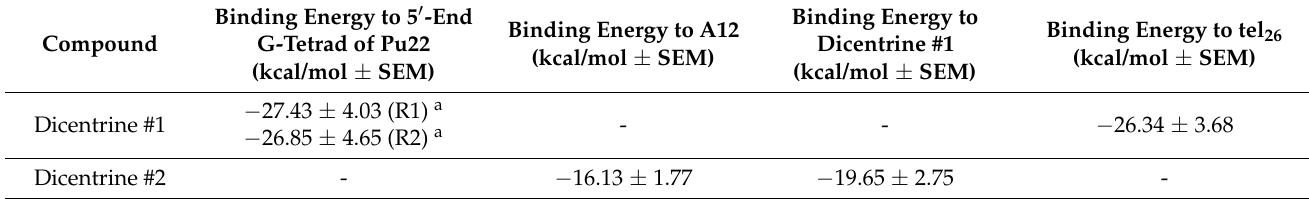
Table 4. Delta energy of the binding of Dicentrine to the Pu22 and tel 26 G-quadruplexes as predicted using the MM-GBSA